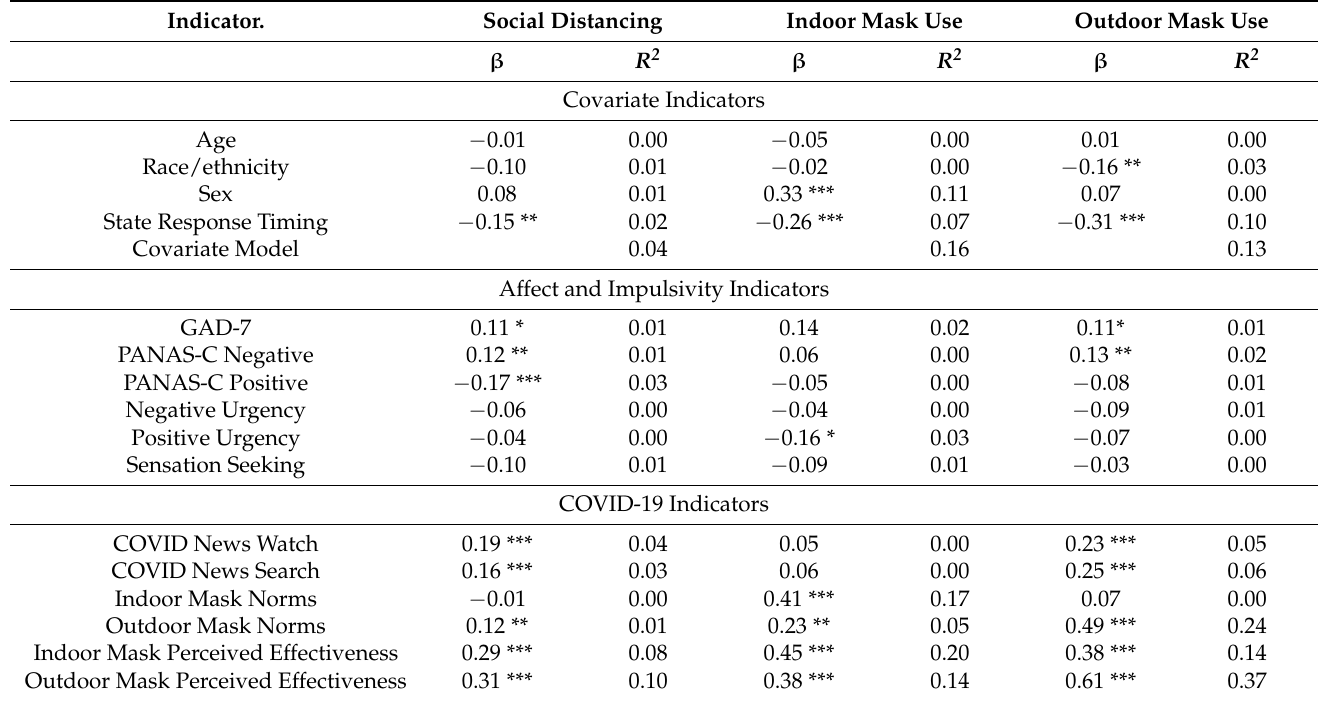
Table 2. Main effects for COVID-19 behavior engagement as a function of demographics, affect, impulsivity, news exposure, norms, and perceived behavior effectiveness.